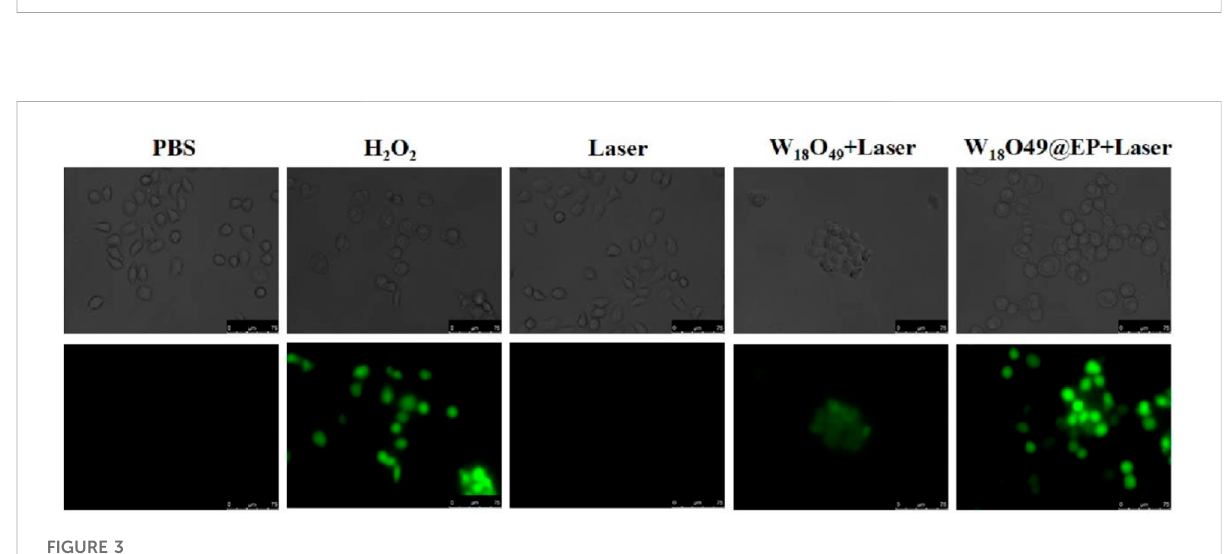
PhotothermalconversioneffectofW 18 O 49 @EPNPs. (A) PhotothermalconversioneffectofW 18 O 49 @EPsolution(1 mg/ml)testedinacentrifuge tube; the data came from a thermal imaging camera. (B) A total of 0.1 ml W 18 O 49 @EP solution (10 mg/ml) was injected into the tumor of a tumor- bearing mouse; the data came from a thermal imaging camera. The laser irradiation was 808 nm and 0.48 W/cm 2 .